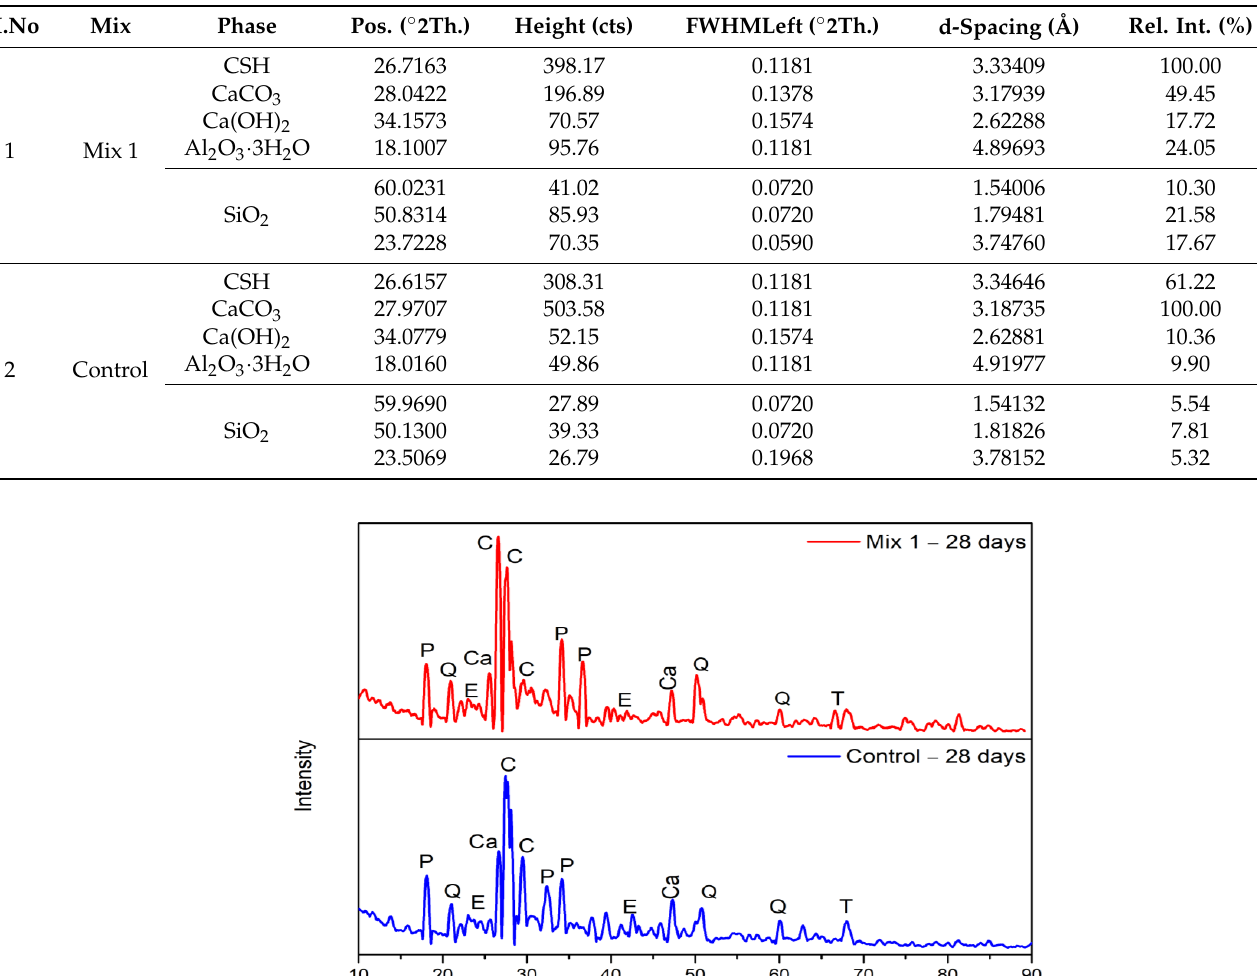
Figure 9. XRD of 7-day hydrated samples (Mix 1 and Control). Table 9. Peak list of 7-day hydrated concrete sample.